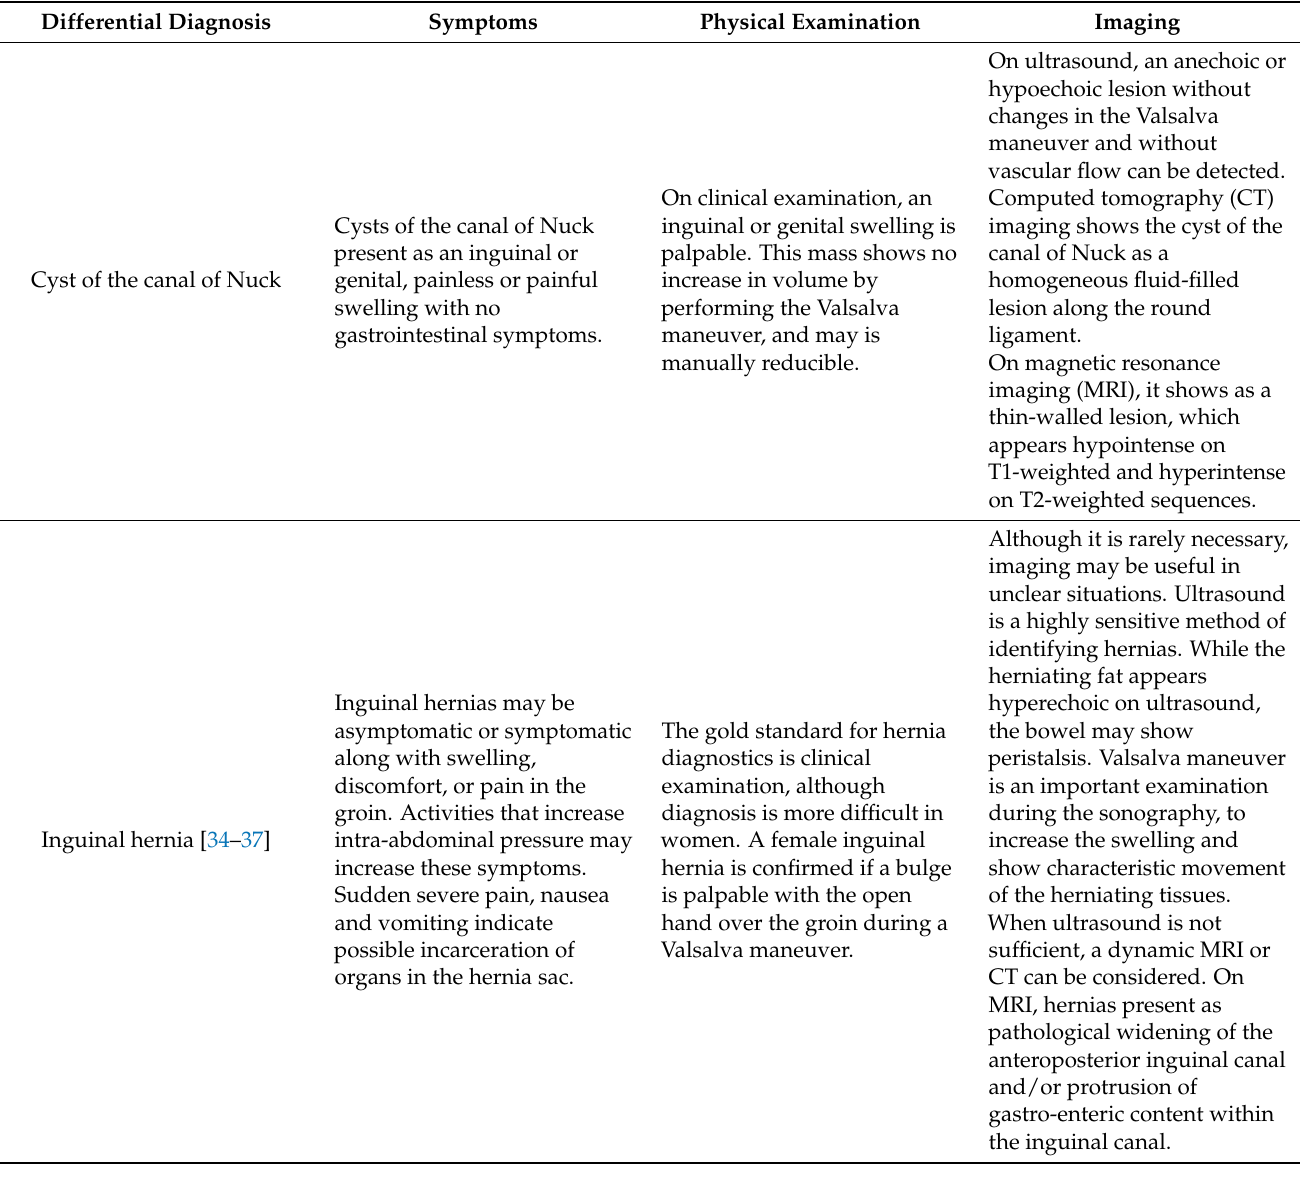
Table 1. Comparison of the Cyst of the canal of Nuck and possible differential